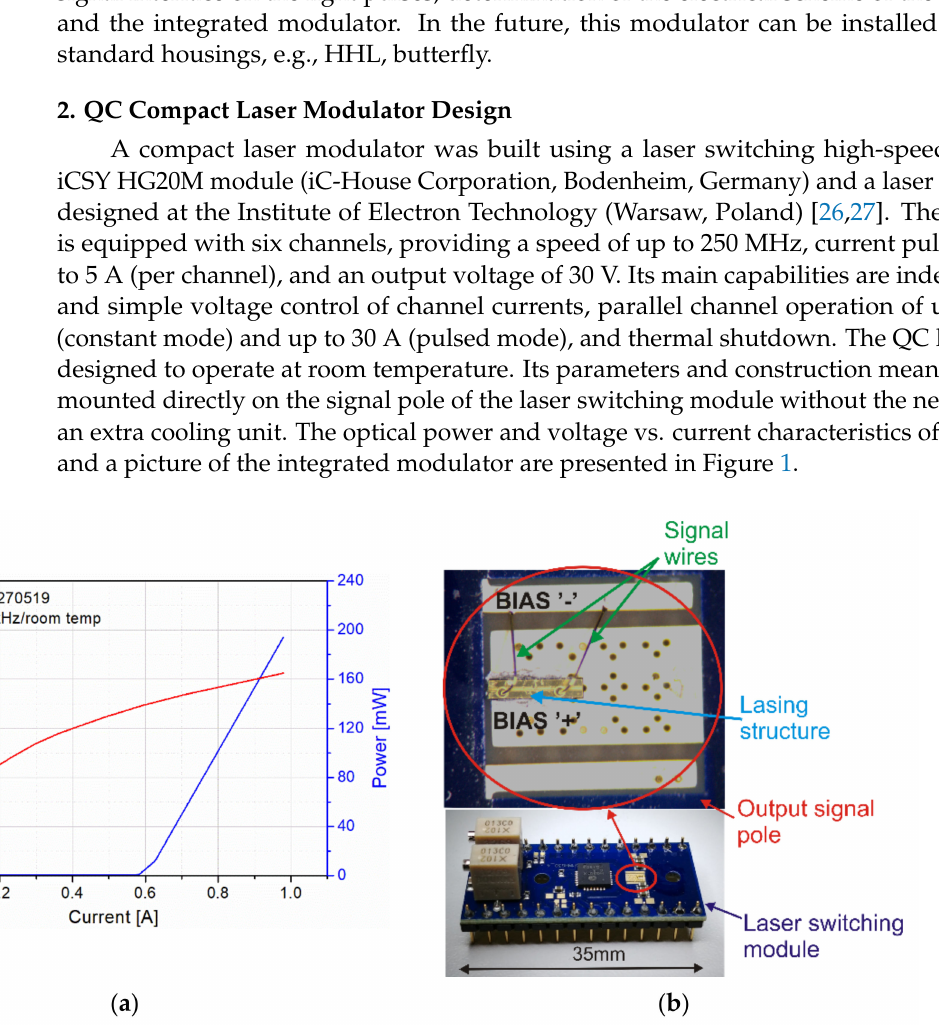
Figure 1. Optical power and voltage vs. current of the mounted QC laser ( a ) and a picture of the integrated IR modulator ( b